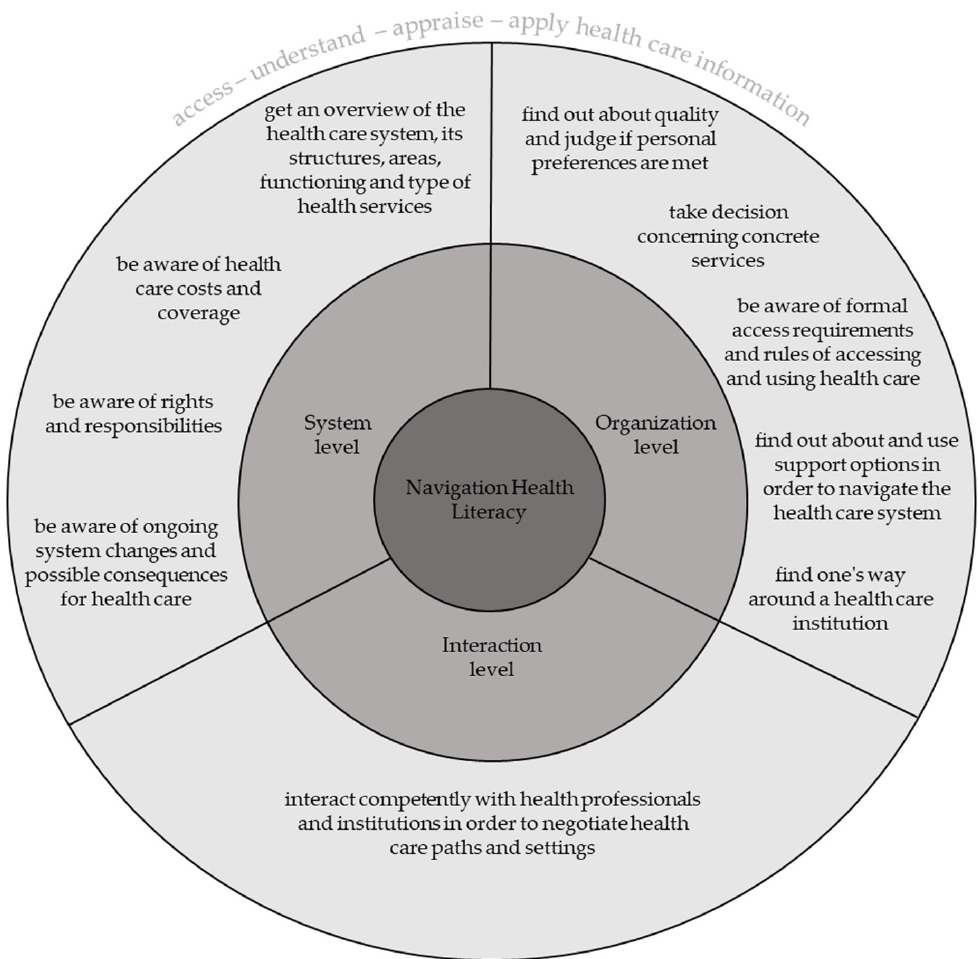
Figure 2. The main HL ‐ NAV tasks.